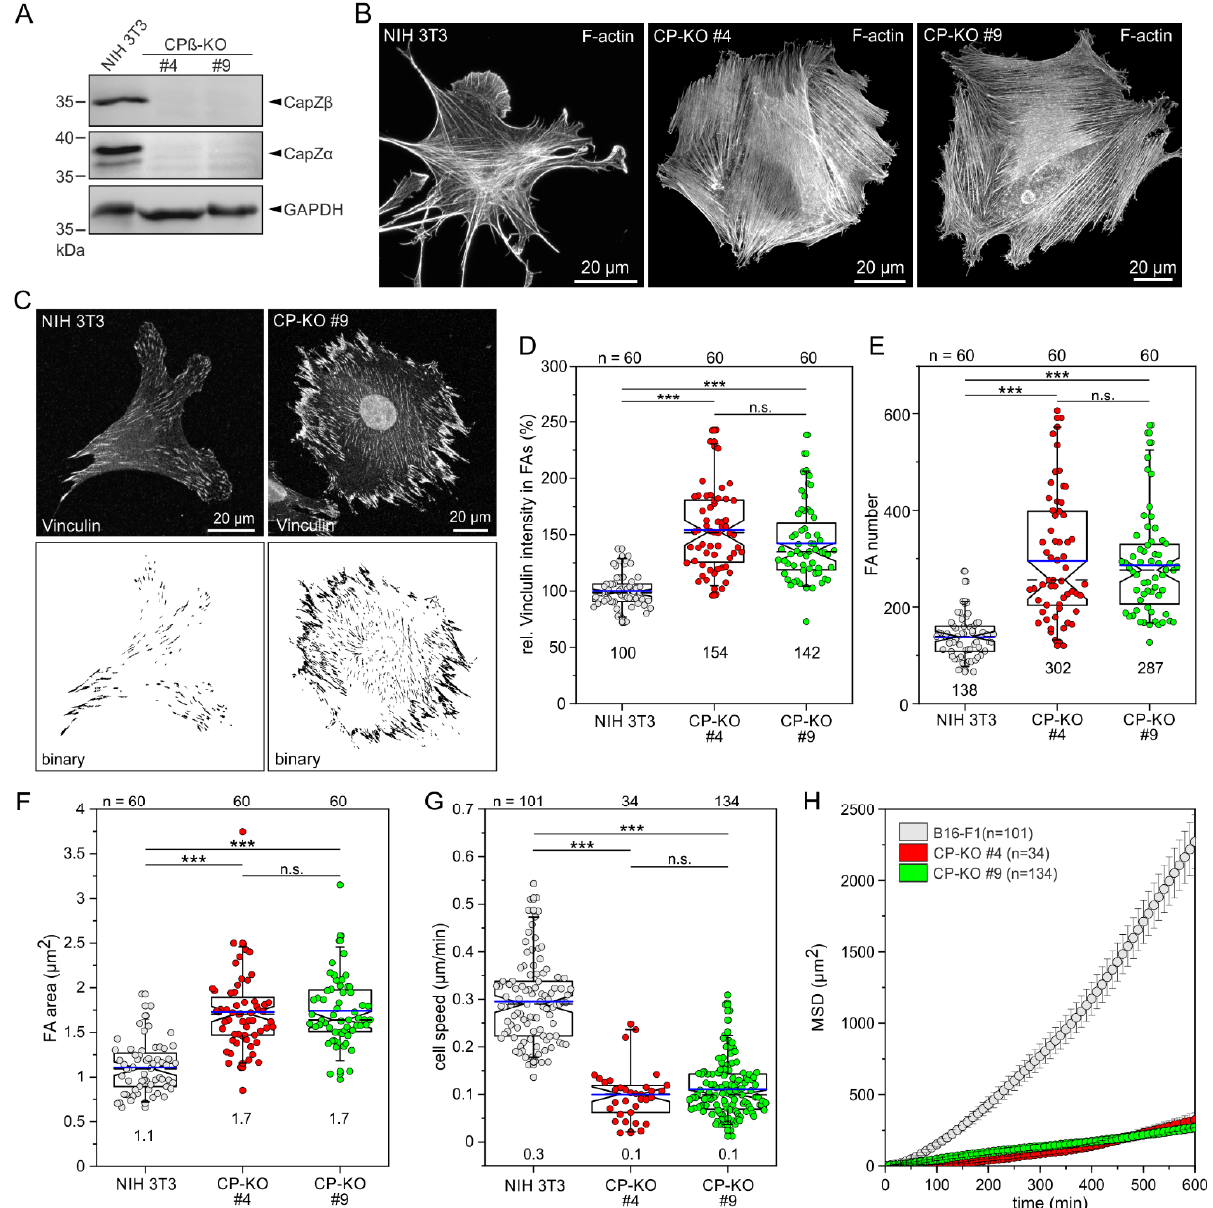
Figure 3. Loss of CP in NIH 3T3 fibroblasts amplifies SF and FA formation and impairs 2D-cell migration. ( A ) Immunoblot confirming the elimination of CPß in two independent single-knockout NIH 3T3 mutants. The loss of the CPß-subunit also led to the almost complete loss of the CPα-subunit. Loading control: GAPDH. ( B ) Morphologies of representative NIH 3T3 and CP-KO mutant cells migrating on fibronectin and stained for F-actin with phalloidin. Note the dramatically increased formation of SFs in the mutant cells. ( C ) Representative micrographs of NIH 3T3 and a derived CP-KO mutant cell displaying vinculin staining before (upper panel) and after processing with a customized Fiji macro (lower panel). ( D ) Quantification of vinculin intensities in FAs. ( E ) Quantification of FA number. ( F ) Quantification of FA area. ( G ) Loss of CP results in decreased cell speed. ( H ) Analyses of mean square displacement of wild-type versus mutant cells. Respective symbols and error bars represent means ± SEM. ( D – G ) The boxes in box plots indicate 50% (25–75%) and whiskers (5–95%) of all measurements, with dashed black lines depicting the medians and arithmetic means highlighted in blue. Non-parametric Kruskal–Wallis test and Dunn’s Multiple Comparison test were used to reveal statistically significant differences between datasets. *** p ≤ 0.001; n.s.: not significant. n: number of cells analyzed from at least three independent experiments.